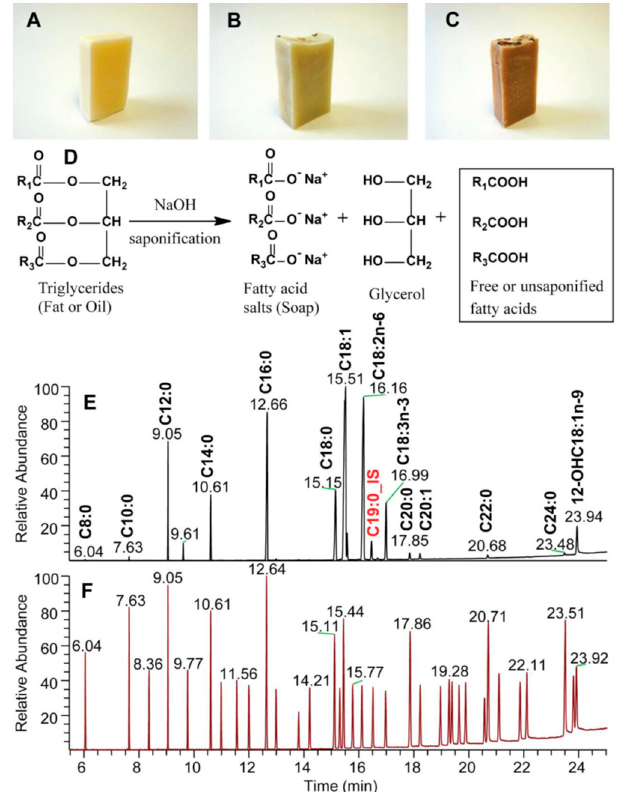
Figure 1. Base bar ( A ), forest grove ( B ), and hibiscus rose hip ( C ) natural soaps manufactured using cold saponification. ( D ) Chemical equation showing the cold saponification reaction associated with the manufactured natural soap products. Gas Chromatography/ Flame Ionization Detector (GC/FID) chromatogram of the fatty acid composition of a natural soap sample ( E ) relative to that of a commercial standard mix ( F ) of fatty acid standards (Supelco 37 components mix) used as reference during sample analyses. Table 1. Fatty acid composition of the combined oils and butter used to manufacture different natural soaps.